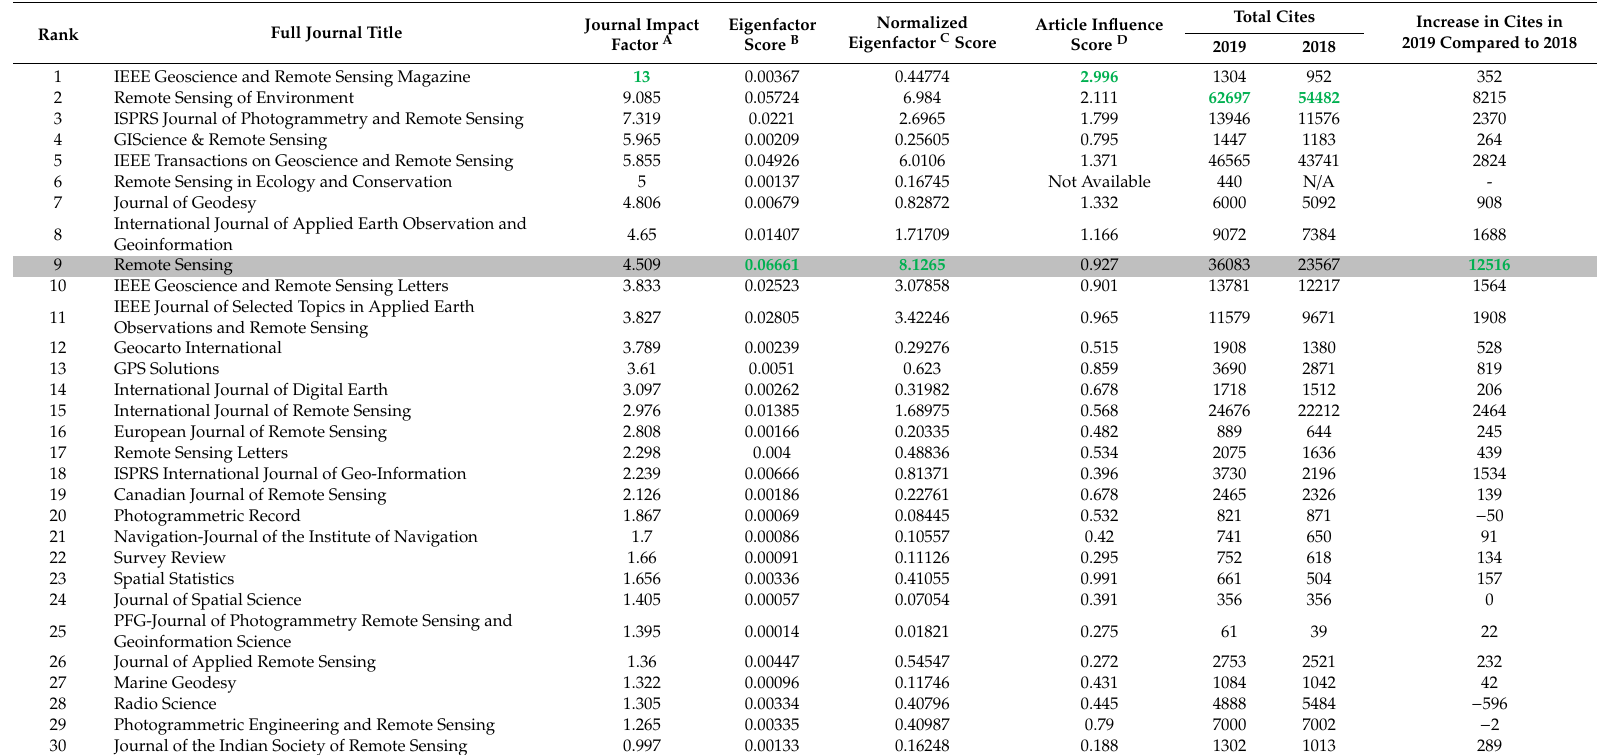
Table 1. Critical remote sensing international journal performance